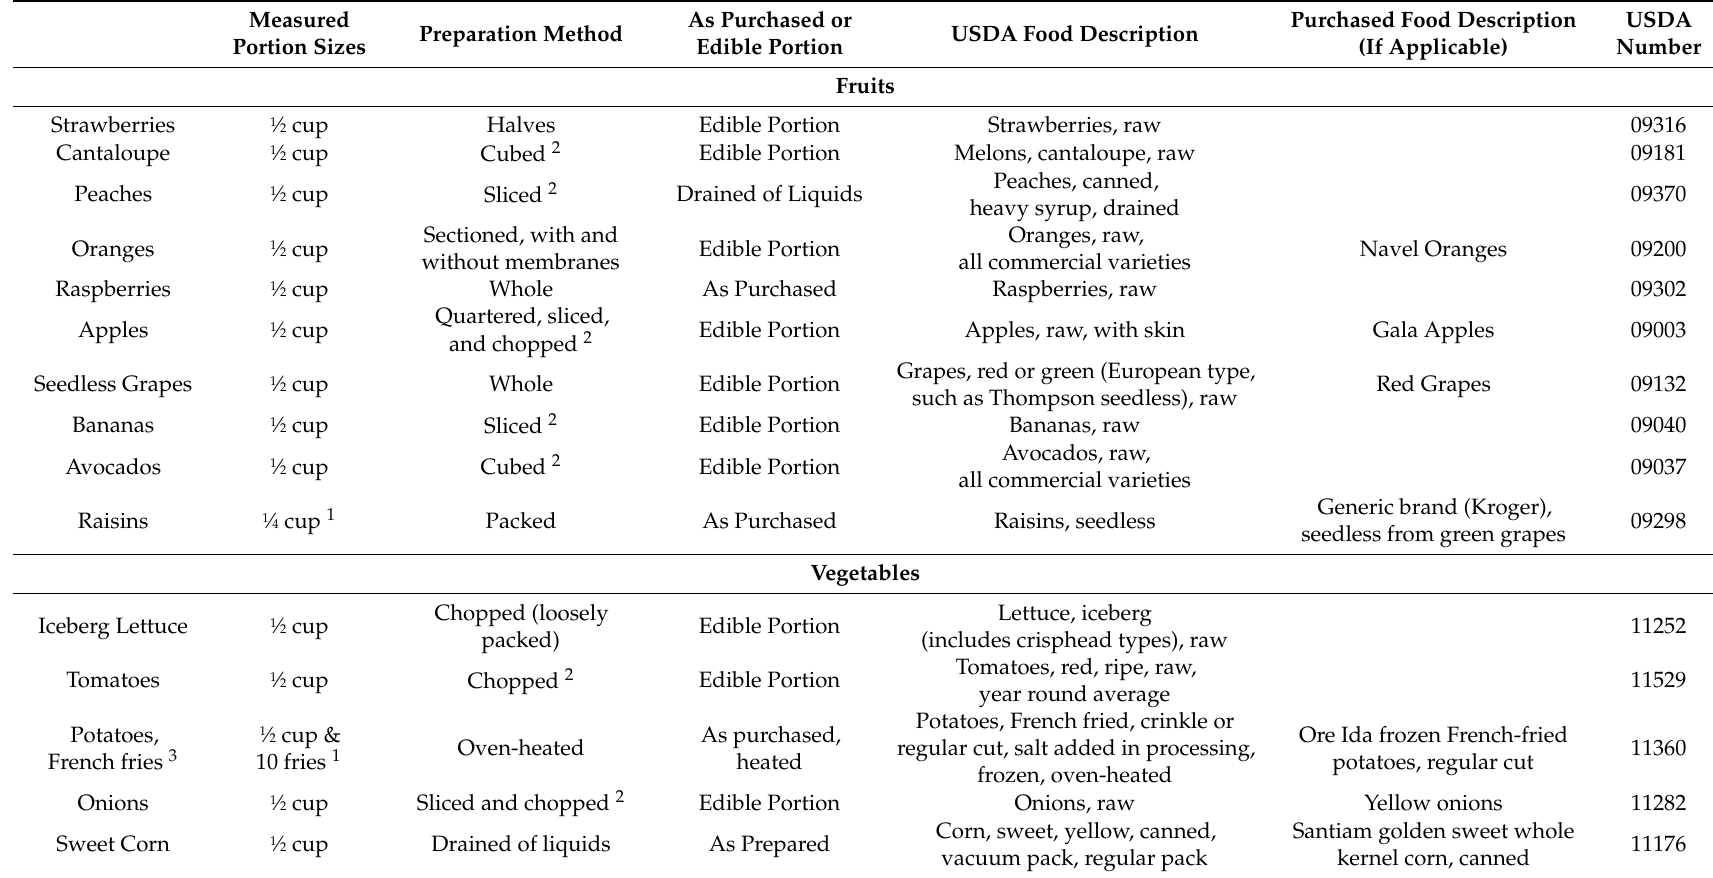
Table 1. Descriptions of selected foods and preparation methods used for